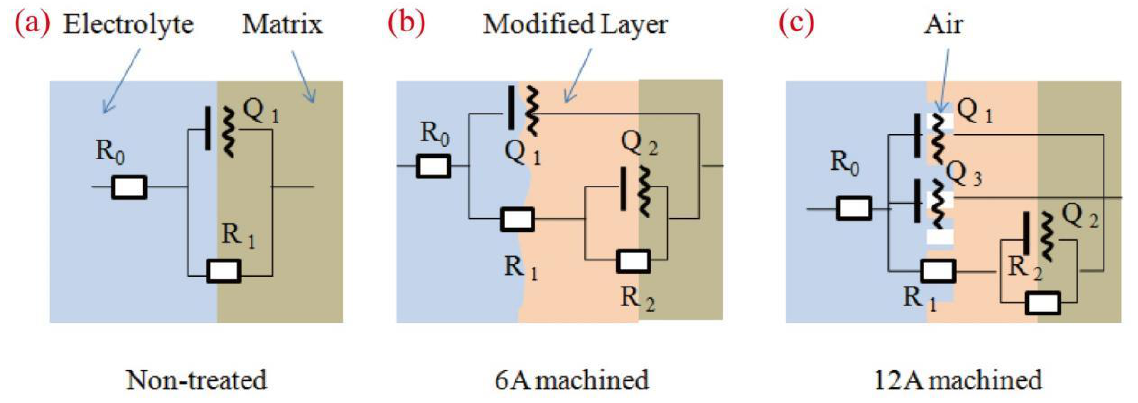
Figure 10. Electrochemical equivalent circuits for EIS of the samples: ( a ) the non-treated, ( b ) 6A PMEDA machined surface and ( c ) 12A PMEDA machined surface.